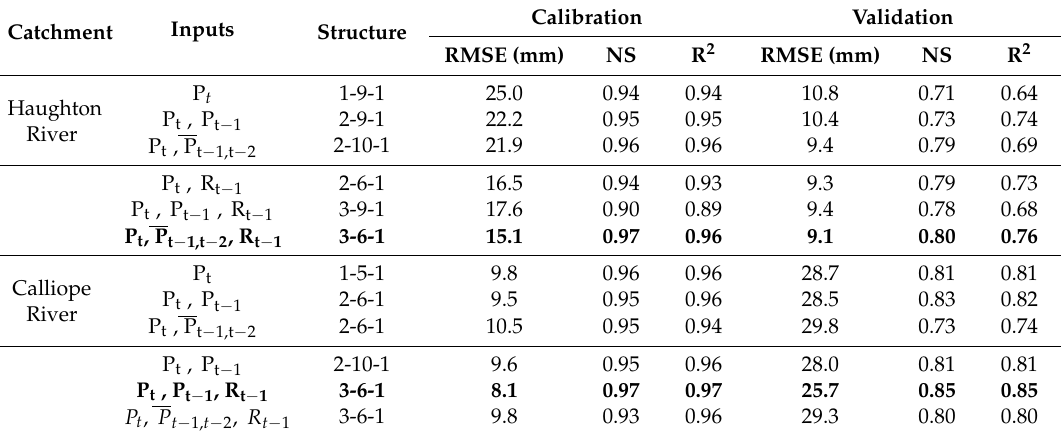
Table 4. Results of monthly time series modelling by Artificial Neural Network (ANN) with hydro-climatic inputs during calibration and validation.